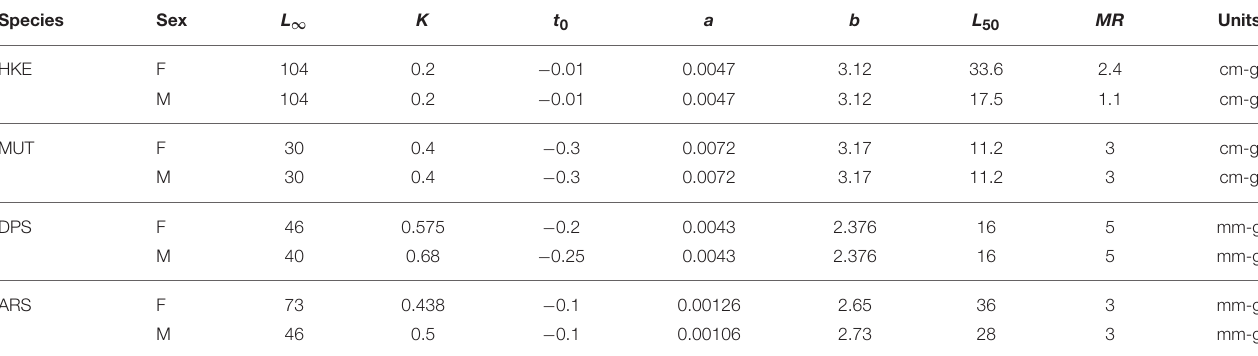
TABLE 2 | Biological parameters per stock L ∞ , K , and t 0 von Bertalanffy growth parameters, and b length-weight relationship coefficients, size at first maturity ( L 50 ), and maturity range (MR). Species Sex L ∞ K HKE